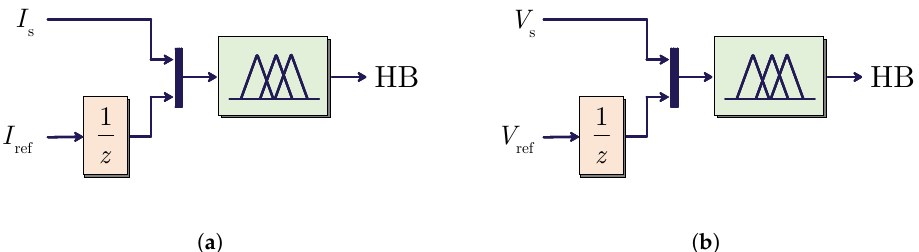
Figure 5. Calculating the Adaptive Hysteresis Band (HB) using fuzzy logic: ( a ) for current and ( b ) for